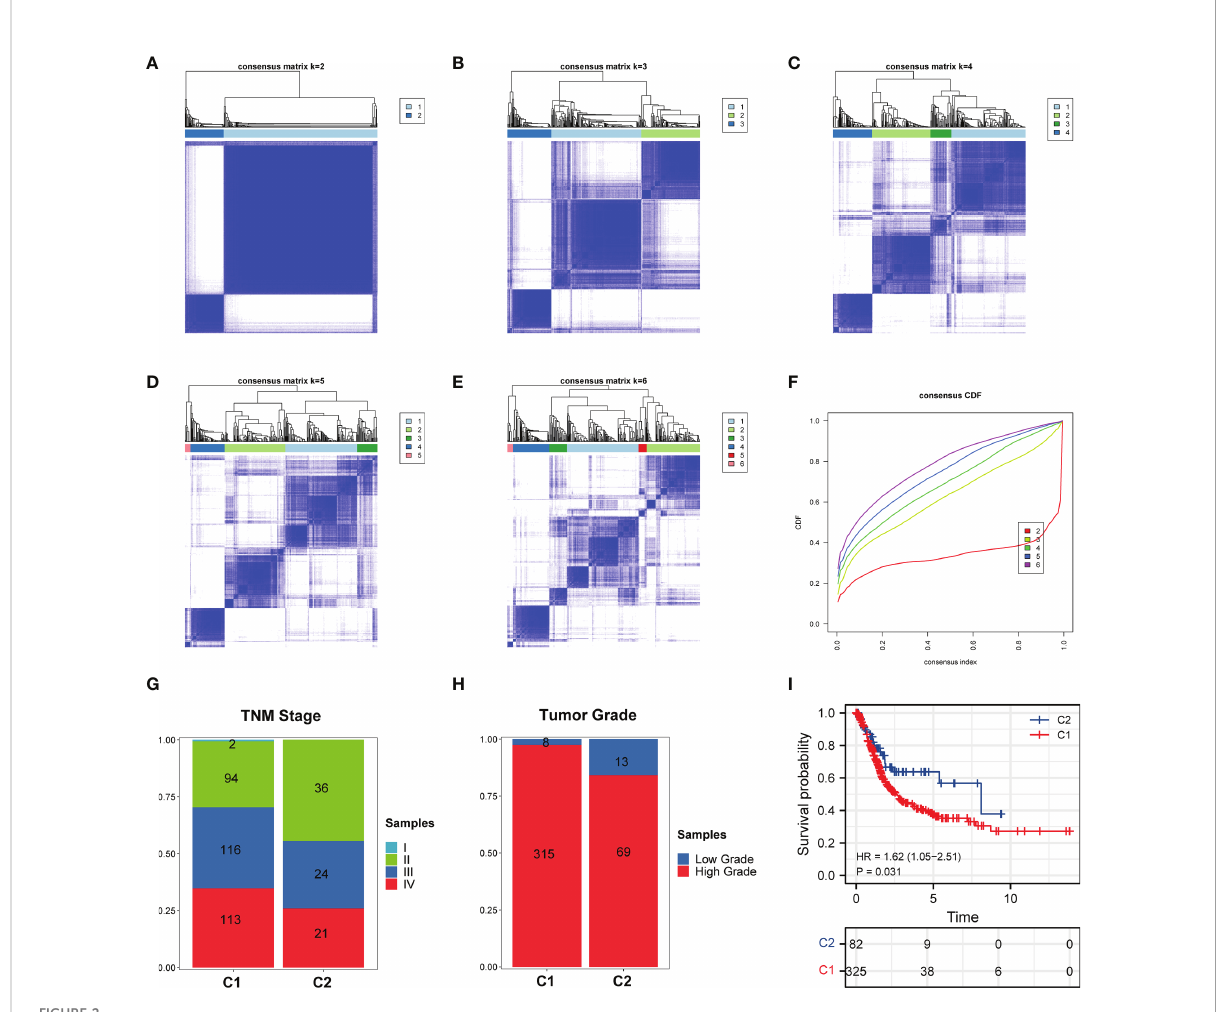
FIGURE 2 Consensus clustering analysis of ferroptosis regulators in BCa. (A – E) Consensus clustering matrix for (A) k = 2, (B) k = 3, (C) k = 4, (D) k = 5, (E) k = 6. (F) Cumulative curves for k = 2 – 6. (G, H) Distribution of C1/C2 in BCa (G) TNM stage and (H) tumor grade. (I) Kaplan-Meier curves showing OS of C1/C2. C1 and C2 represents Cluster 1 and Cluster 2,